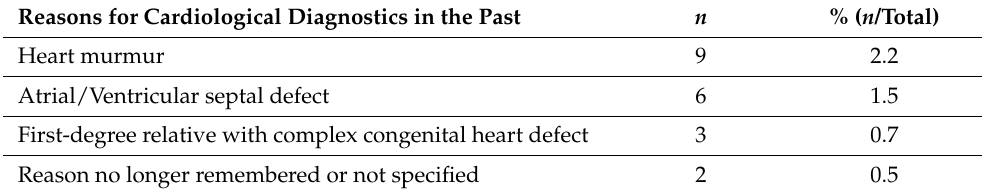
Table 5. Reasons for previous cardiological diagnostics in study participants, expressed as a percent- age of the total risk profiles received ( n =